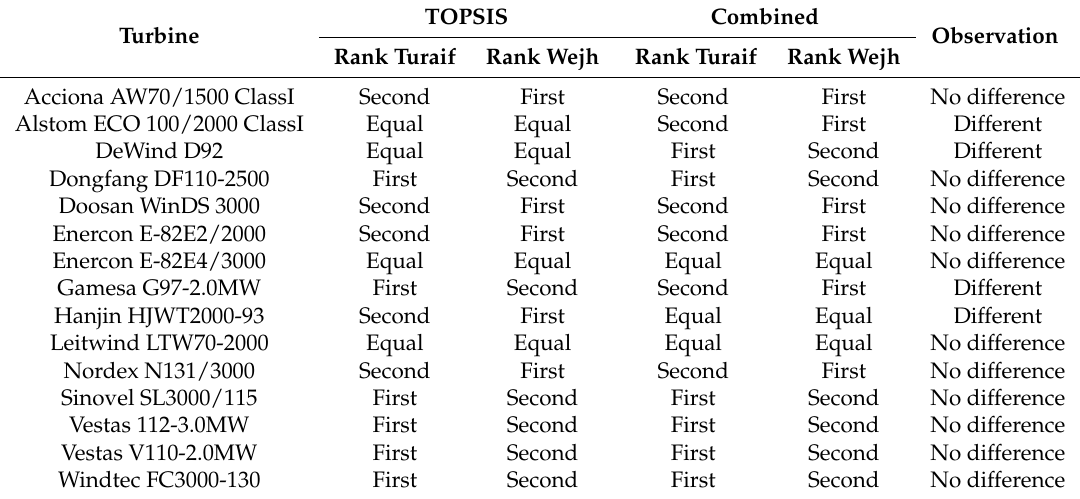
Table 7. Comparative rankings using TOPSIS and combined methods